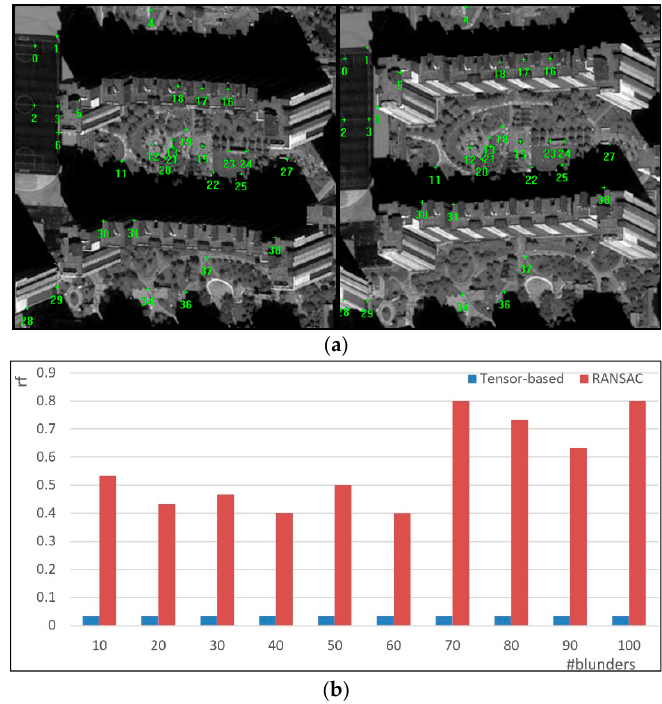
Figure 8. A comparison of RANSAC and tensor-based gross error detection: ( a ) manual selected tie points; and ( b ) results of the comparison.